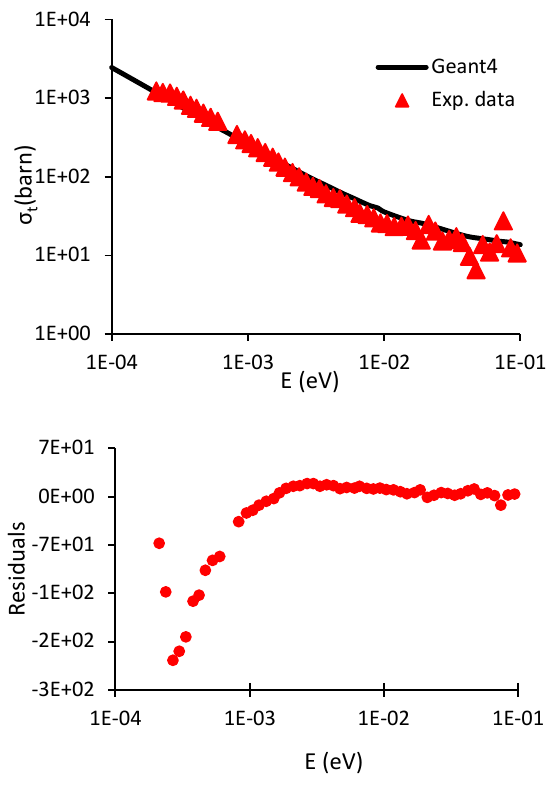
Fig. 8. Simulation of nanodiamonds total cross-section in